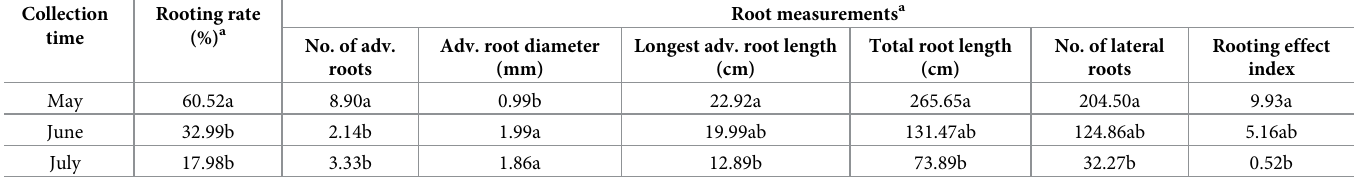
Table 5. Effect of collection time on the rooting rate and other root related traits of PWD resistant stem cuttings. Collection Rooting rate time (%)